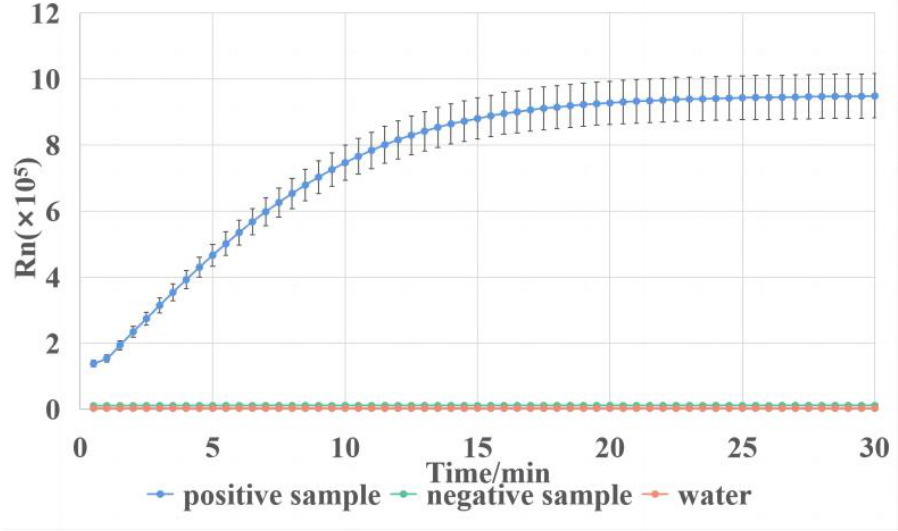
Figure 5. Fluorescent signals of CRISPR reaction on LAMP reaction products using the first set of primers.